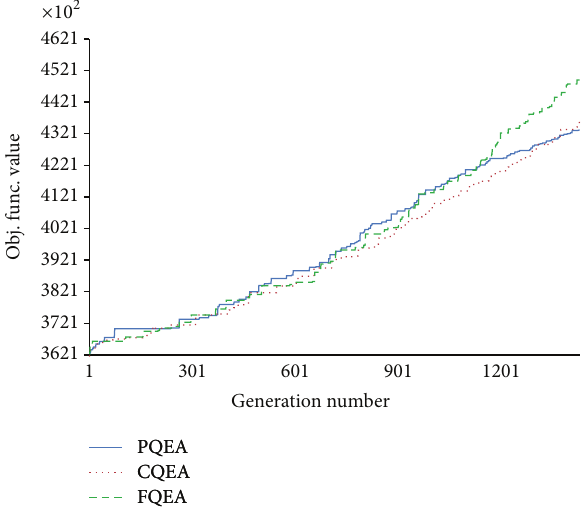
Figure 22: Convergence graph of PQEA, CQEA, and FQEA on 0-1 knapsack problem with multiple strongly correlated data instances with number of items, 𝑀 , being 5000 and capacity, 𝐶 , being 5% of total